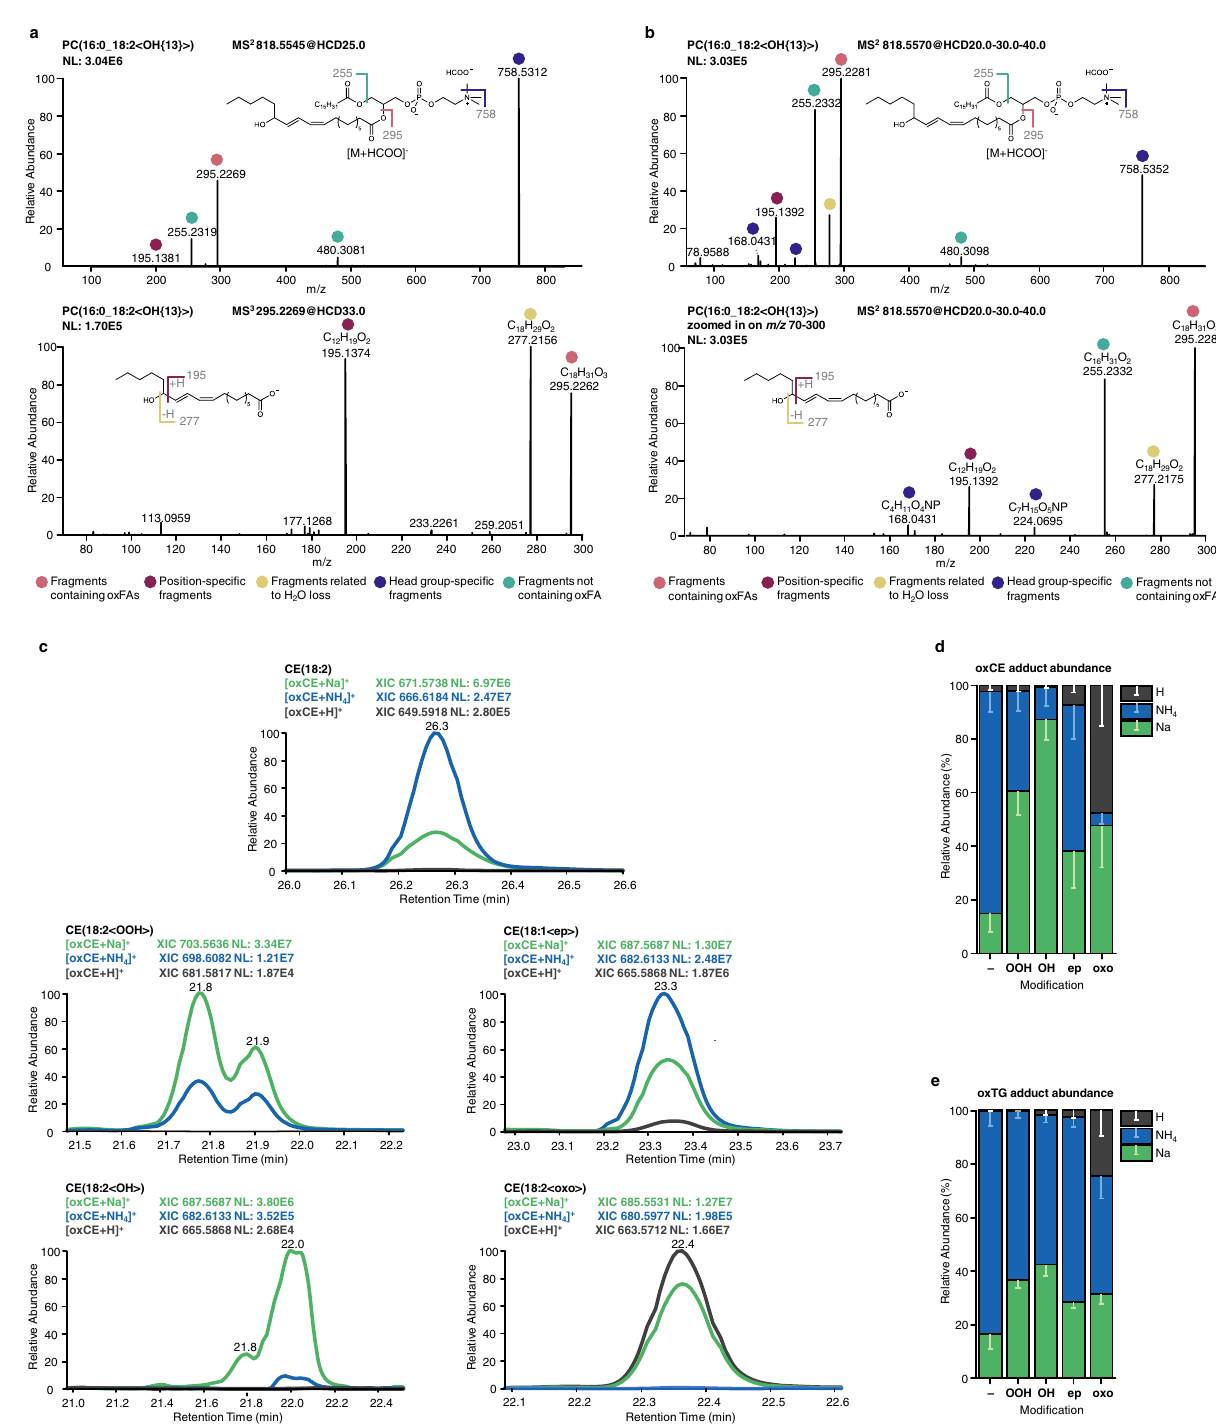
Fig. 1 | Optimization of MS and MS2 parameters for the structural elucidation of oxidized complex lipids structures. Tandem mass spectrometry analysis of oxidizedPC lipid using multistageMS3 ( a ) oroptimizedelevatedenergy stepped HCD MS2 experiments ( b ) both allowed structural assignment of PC(16:0_18:2<OH{13}>).Positiveionmodeionizationadductsforinvitrooxidized neutral lipids showed modi fi cation type-speci fi c preferences. Qualitative ( c ; illustrated using extracted ion chromatograms for oxCE(18:2) species) and